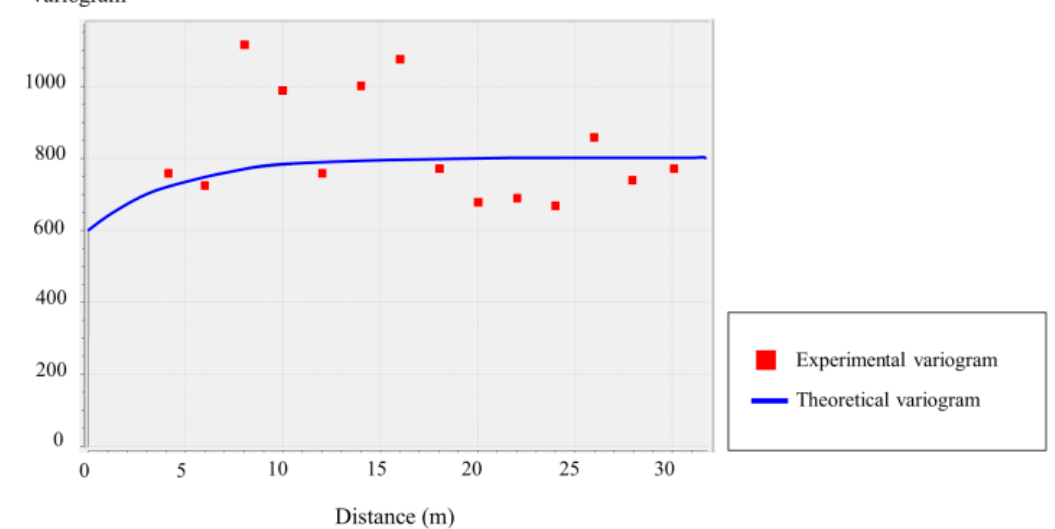
Figure 6. Variogram modeling of the Zn content of the target area. 203